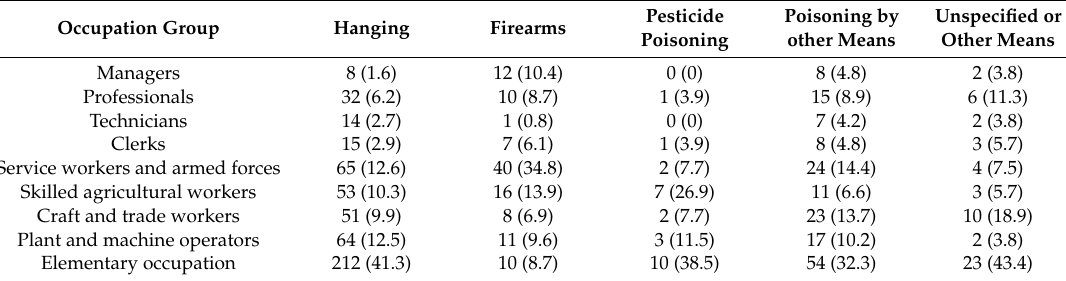
Table 2. Methods of suicide by occupation group (n = 877).